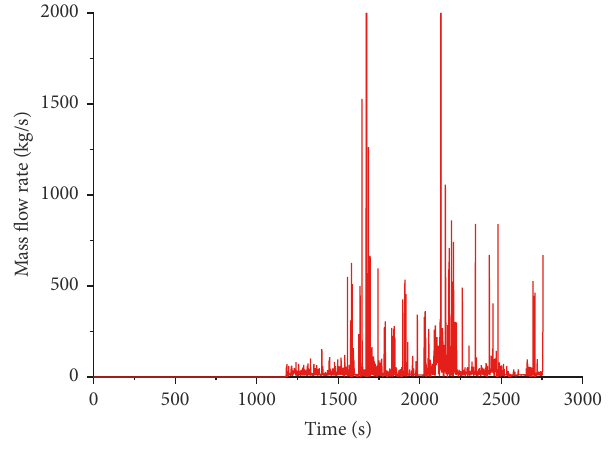
Figure 28: ADS-4B discharge flow rate.